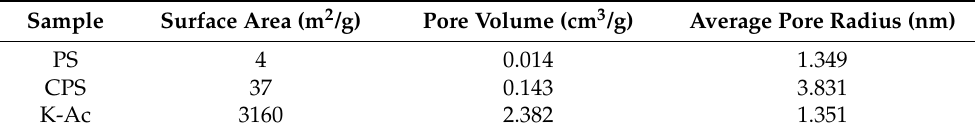
Table 1. The specific surface area parameter of as-prepared samples.